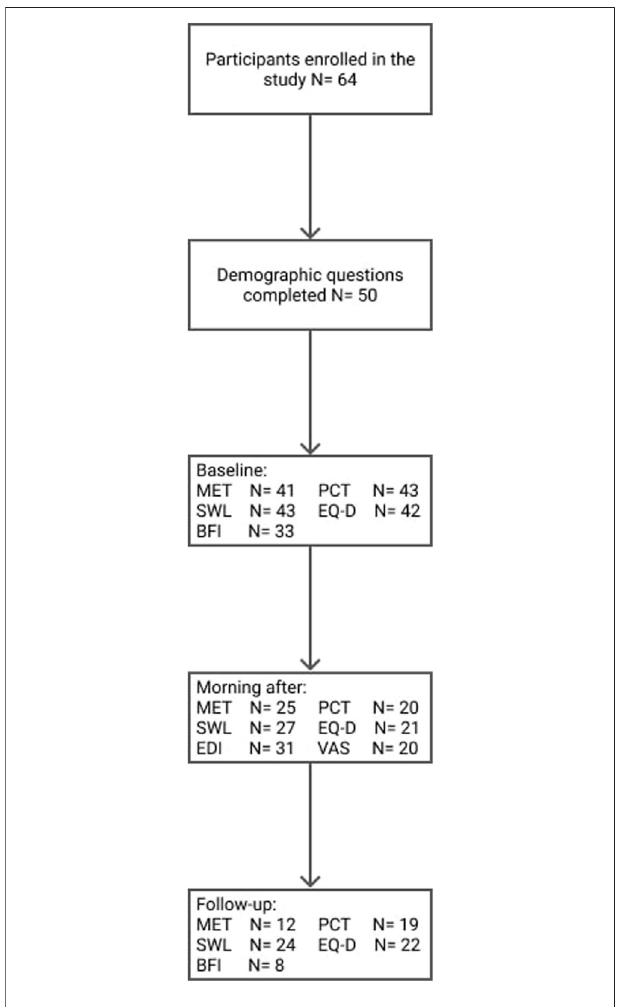
FIGURE 1 | Flow-chart depicting participants ’